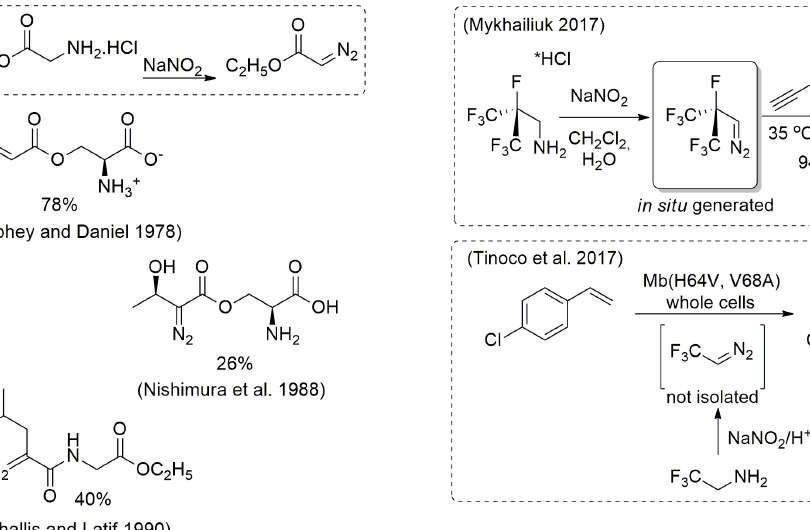
Figure 30 - Some applications of the amine diazotization method to produce ethyl diazoacetate.